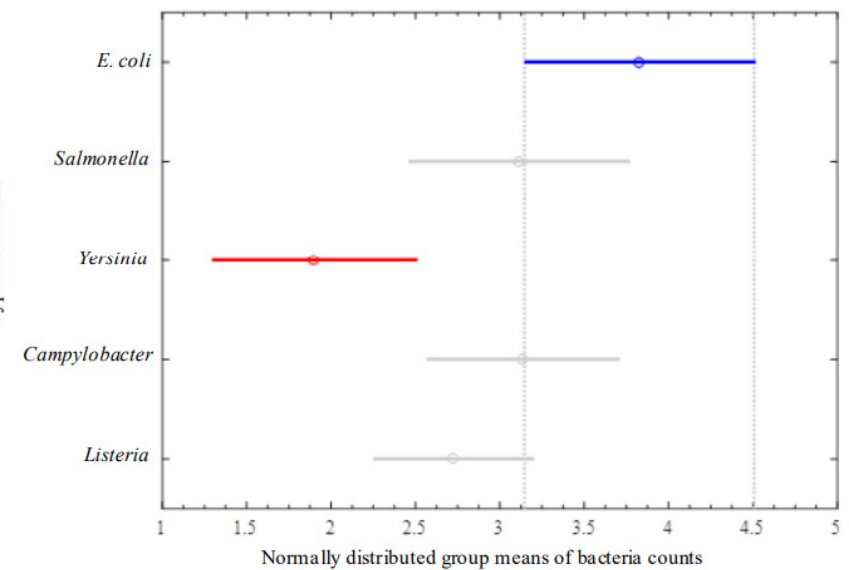
Figure 4. Multiple comparison test to verify whether a mean significant difference existed between any two bacterial groups.